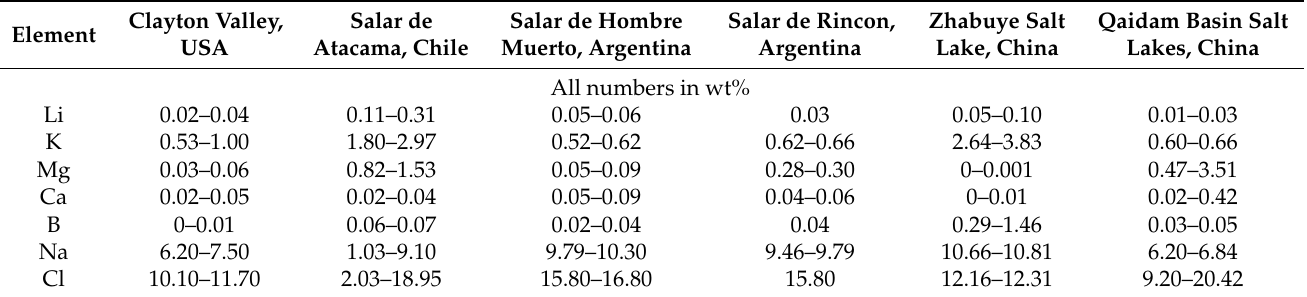
Table 1. Selected typical lithium-bearing brine compositions; other elements and compounds may also be present